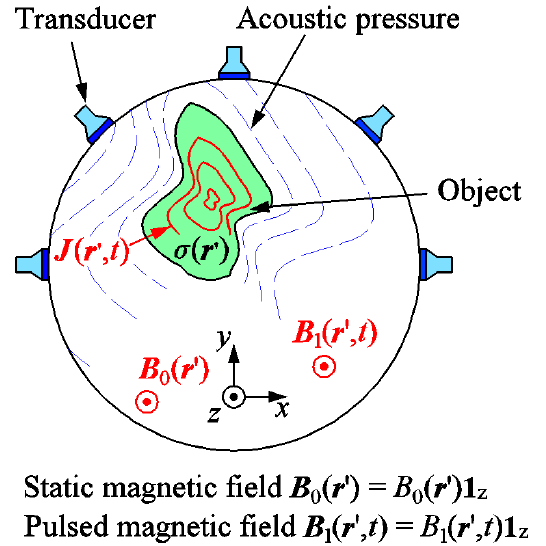
Figure 1. Illustration of the magnetoacoustic tomography with magnetic induction (MAT-MI) concept.